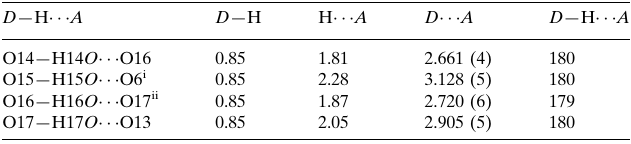
Hydrogen-bond geometry (A˚ , (cid:2) ). D —H (cid:1)(cid:1)(cid:1) A